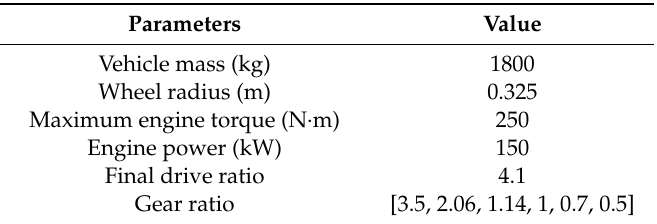
Table 2. Basic CarSim vehicle model